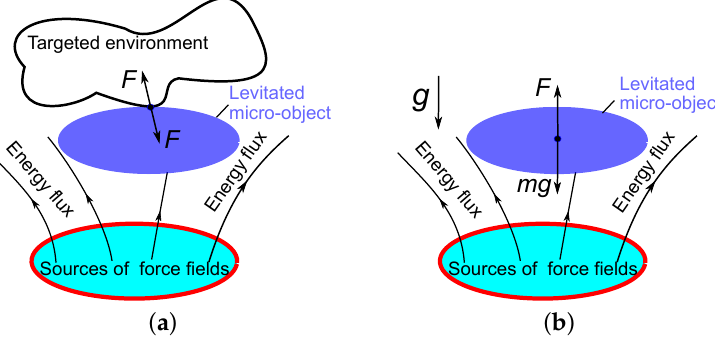
Figure 1. Concepts of levitating micro-actuators ( F is the generated force by the actuator; m is the mass of the levitated micro-object; g is the gravity acceleration): ( a ) the levitating micro-actuator acting on the environment; ( b ) the levitating micro-actuator acting without targeted